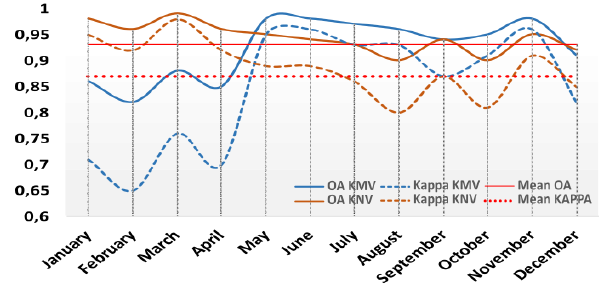
Figure 4. Kappa index and overall accuracy (OA) of water classification along to the year for the two Sentinel-2 tiles (KMV and KNV)